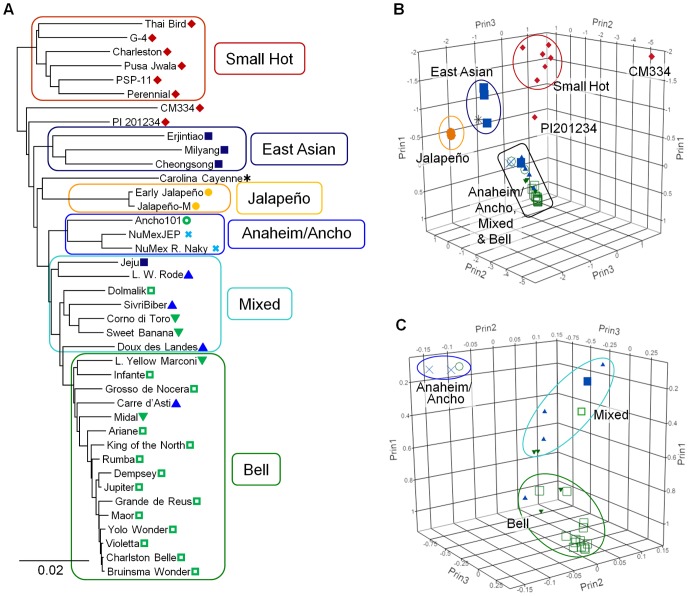
Principle component analysis & phylogram derived from SPP markers.(A) A representative Fitch and Margoliash phylogram with branch lengths reflecting phylogenetic distances based on Nei and Li genetic distances. Boxed clades and labels correspond to clusters based on Structure simulation at K = 6. Long Yellow Marconi and Lange Westlandse Rode are abbreviated L. Yellow Marconi and L. W. Rode, respectively. (B) Graph showing the coordinates of the first 3 principle components for each variety. Clusters are circled and labeled. Non-clustered lines PI 201234 and CM334 are labeled separately. In this view the Anaheim/Ancho, Mixed and Bell clusters, boxed in black, are difficult discriminate, therefore, this area was expanded in (C) which shows the arrangement of these clusters. Symbols correspond to those representing horticultural classifications in Figure 4.